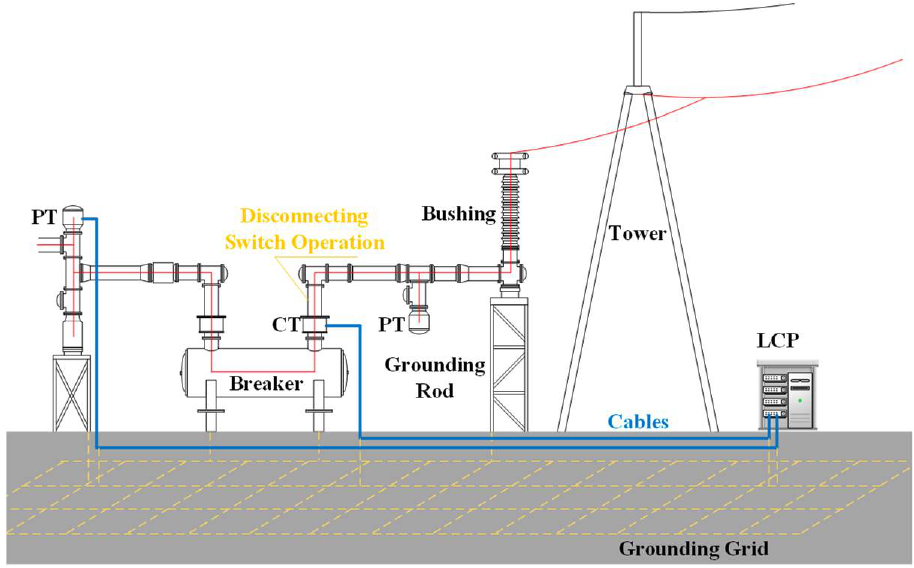
Figure 1. Layout of localized relay protection device for smart substation.